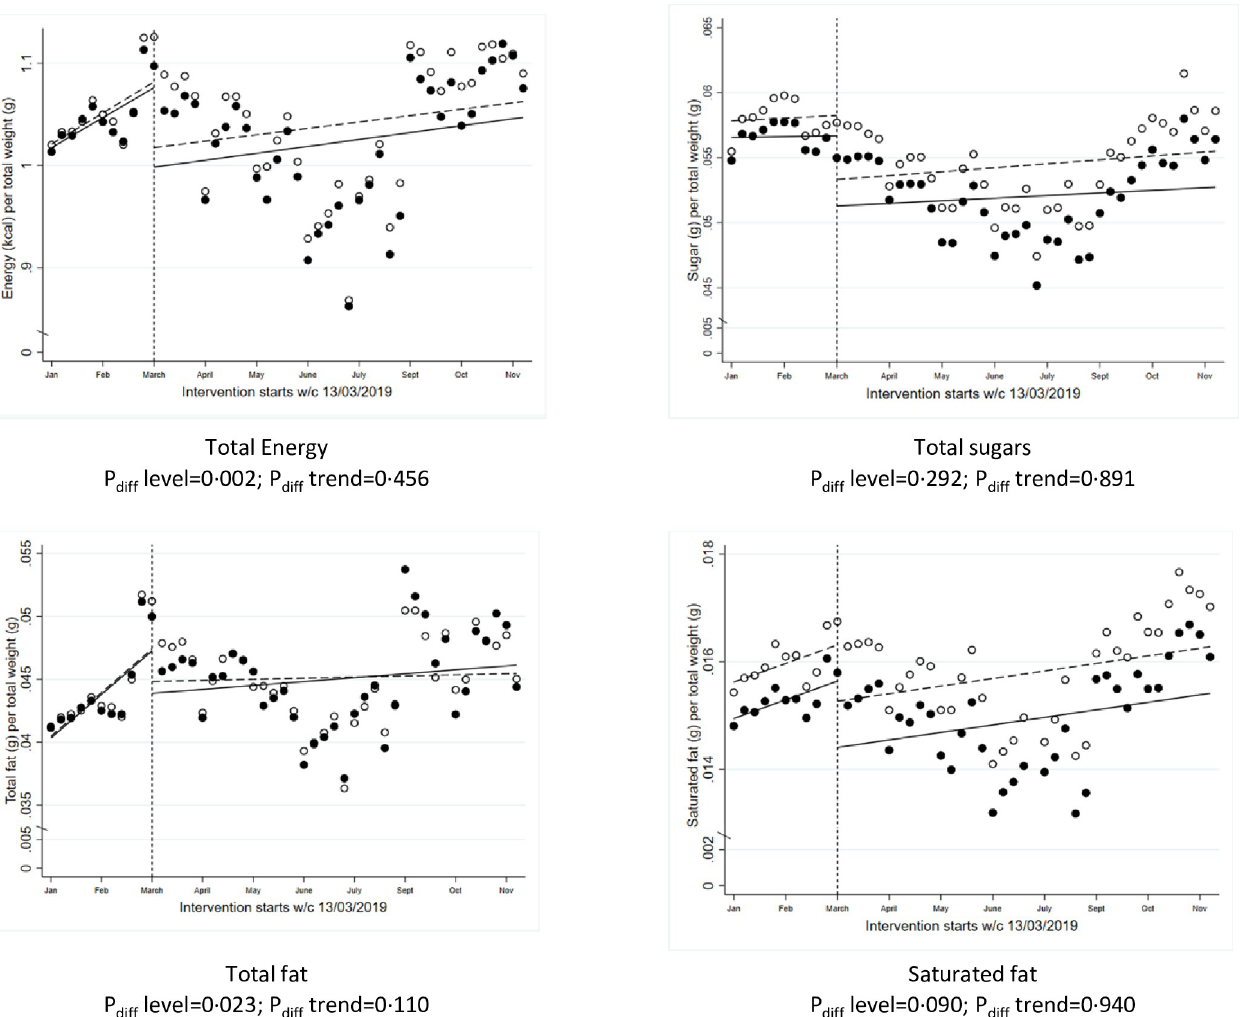
Fig 2. ITS analysis showing level and trend changes in calories and nutrients from all sales (averages per store/week) during the implementation of the chocolate confectionery availability study from 1 January 2019 to 24 November 2019. � Solid dots (observed) and lines (modelled) represent intervention stores; white dots (observed) and dotted lines (modelled) represent control stores. ITS, interrupted time